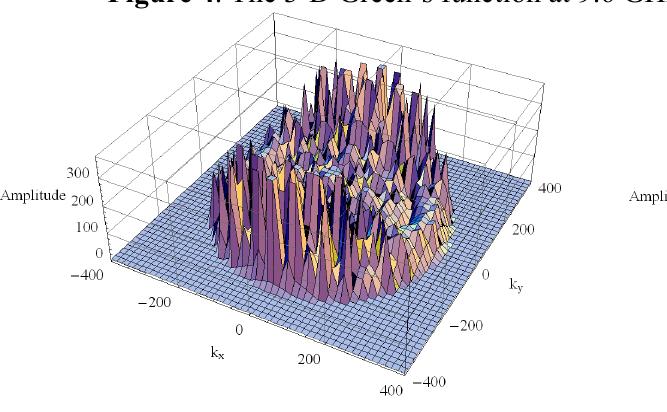
Figure 4 . The 3-D Green’s function at 9.6 GHz: (a) real part and (b) imaginary